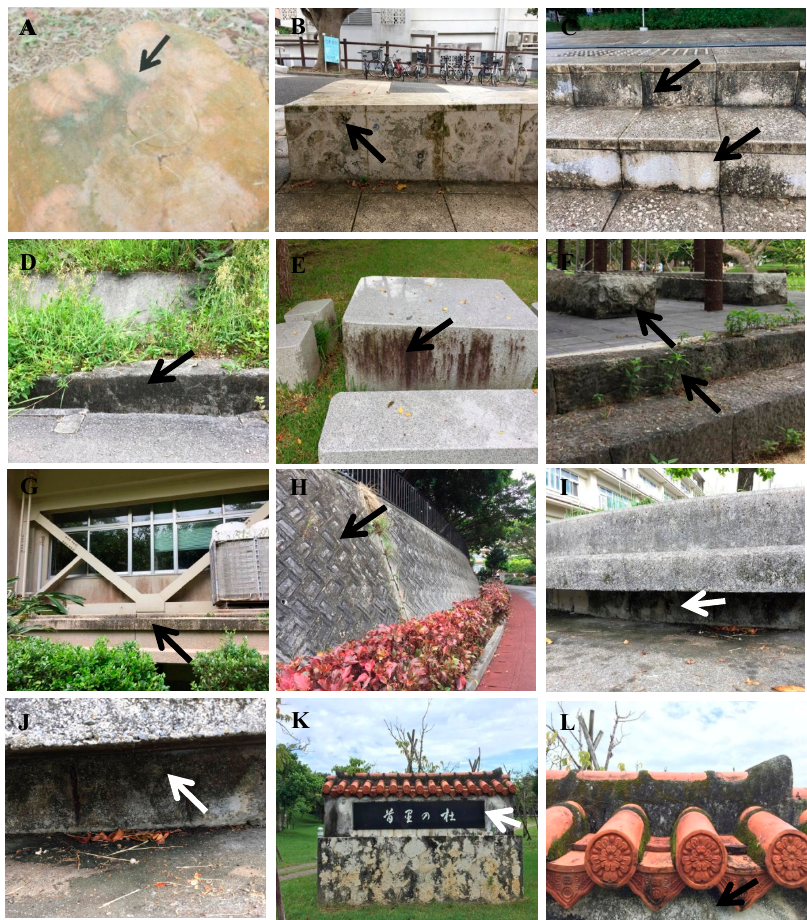
Figure 2. Pictures of blackened sampling points (arrows). ( A ) tree stump, Ru1; ( B ) limestone bench, Ru3; ( C ) limestone stairs, Ru4 and Ru5; ( D ) side wall of ditch, Ryu1; ( E ) side wall of a stone desk, Ryu2; ( F ) side wall of stone foundations, Ryu3 and Ryu4; ( G ) wall of a school building, Ryu5; ( H ) road side wall, Ryu7; ( I , J ) bottom part of a concrete bench, Ryu8; ( K ) side of a university monument, Ryu9.1; ( L ) shaded part of the roof of the monument, Ryu9.2.